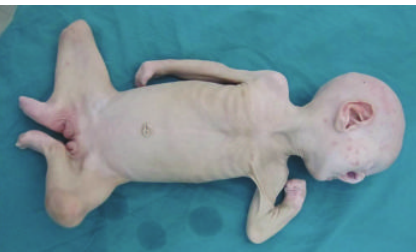
Figure 3: Total view of the proband showing multiple webs at the shoulders, elbows, with huge popliteal webs extending from heel to genitalia, a short sternum and low set umbilicus.